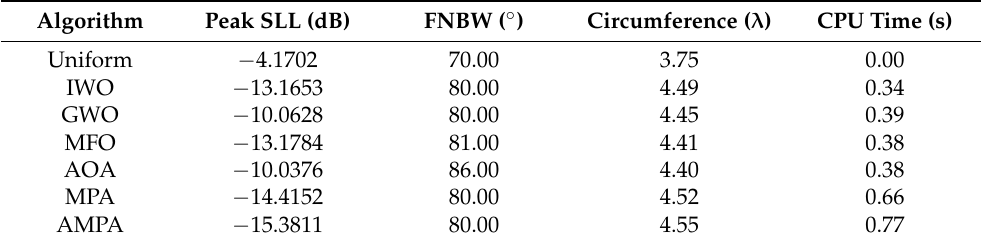
Table 2. Results of 8-element CAA obtained by different algorithms for PSLL minimization.